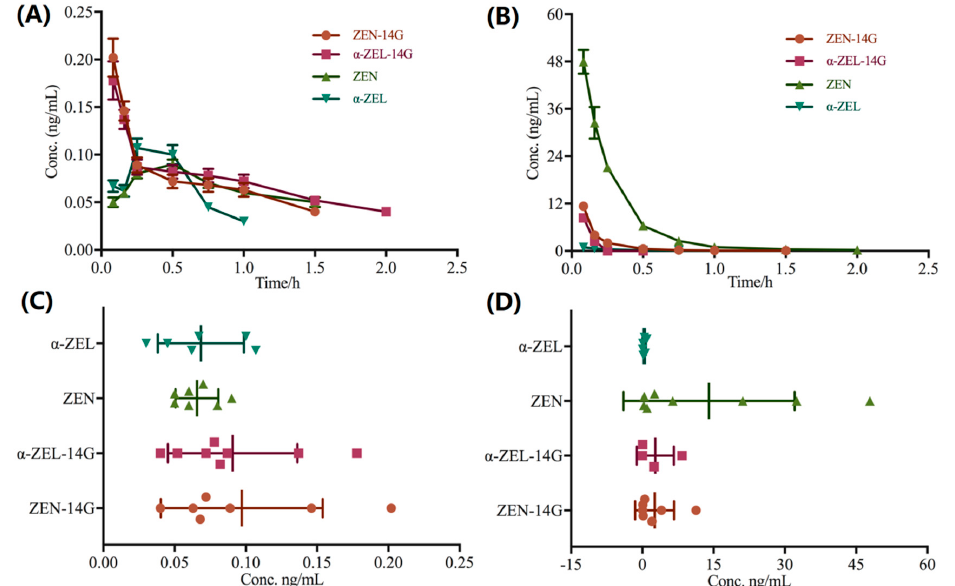
Figure 3. ( A ) Plotted mean plasma concentration versus time curves of ZEN-14G and its quantifiable metabolites ( α -ZEL-14G, α -ZEL, and ZEN) in Wistar rats after oral administration. α -ZEL-14G and ZEN-14G were the principle metabolites in plasma with the same elimination tendency. ( B ) Plotted mean plasma concentration versus time curves of ZEN-14G and its quantifiable metabolites after intravenous injection. ZEN-14G was rapidly converted into ZEN. ( C ) General distribution of ZEN-14G and its quantifiable metabolites in Wistar rats’ plasma after oral administration (the same data set as panel A). ZEN-14G and its quantifiable metabolites were detected at very low levels. ( D ) The distribution of ZEN-14G and its quantifiable metabolites in Wistar rats’ plasma after intravenous administration (the same data set as panel B). ZEN was the predominant derivative in plasma following intravenous injection.